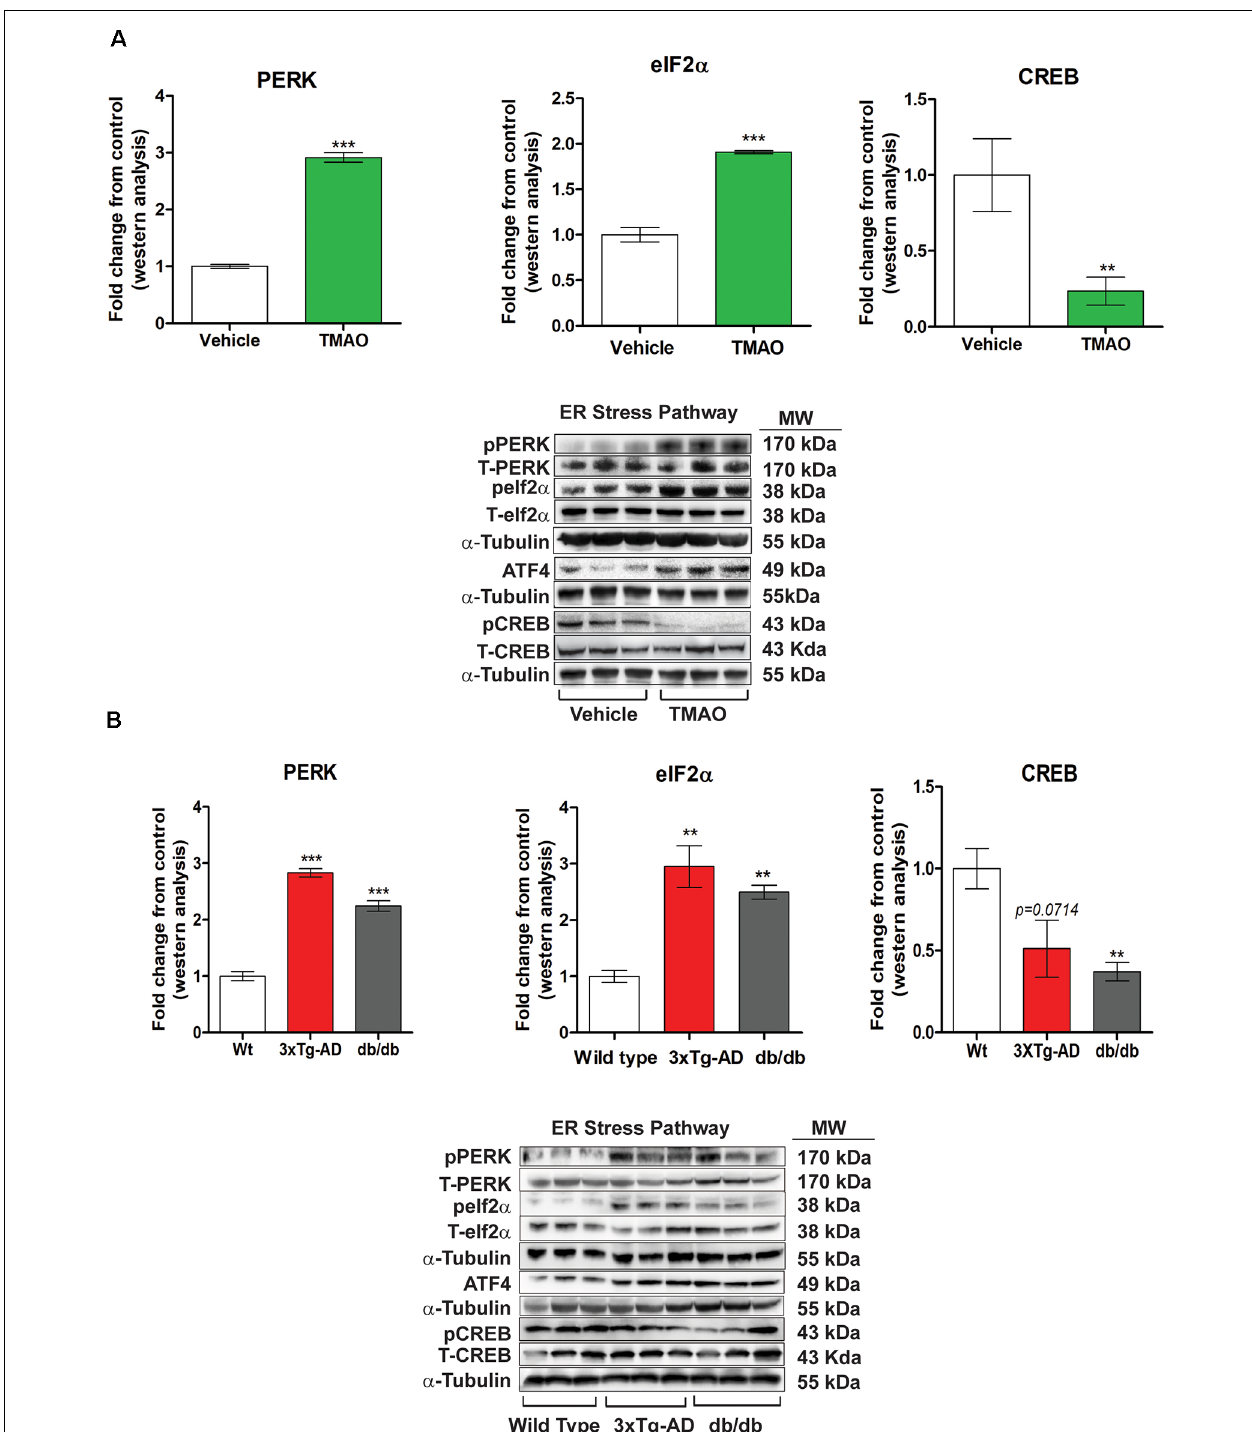
FIGURE 5 | TMAO induces endoplasmic reticulum (ER) stress by activating the PERK pathway of the unfolded protein response (UPR). (A) Hippocampal slices were incubated in ACSF with either 0.03% DMSO (vehicle) or TMAO (50 µ M) for 4 h and then the lysates were subjected to immunoblotting. Representative western blot showing p-PERK, PERK, p-eIF2 α , eIF2 α , ATF4, p-CREB, and CREB levels normalized to α -tubulin. (B) Western blot analysis of p-PERK, PERK, p-eIF2 α , eIF2 α , ATF4, p-CREB, and CREB in hippocampal lysates from control, 3 × Tg-AD and db/db mice aged 8 months. α -tubulin was used as an internal housekeeping protein control. Results are shown as mean ± SEM of three mice per group. ** p < 0.01, *** p < 0.001.